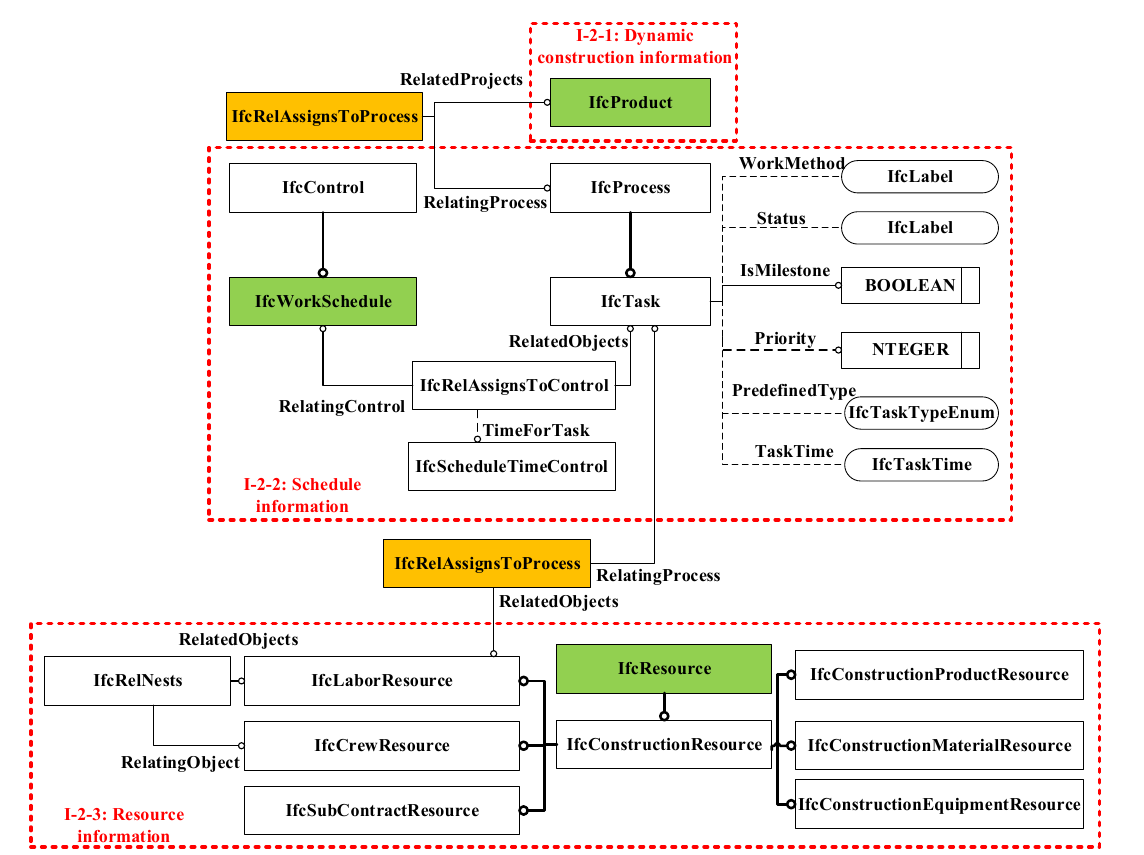
Figure 9. IFC expression of the construction information (I-2).